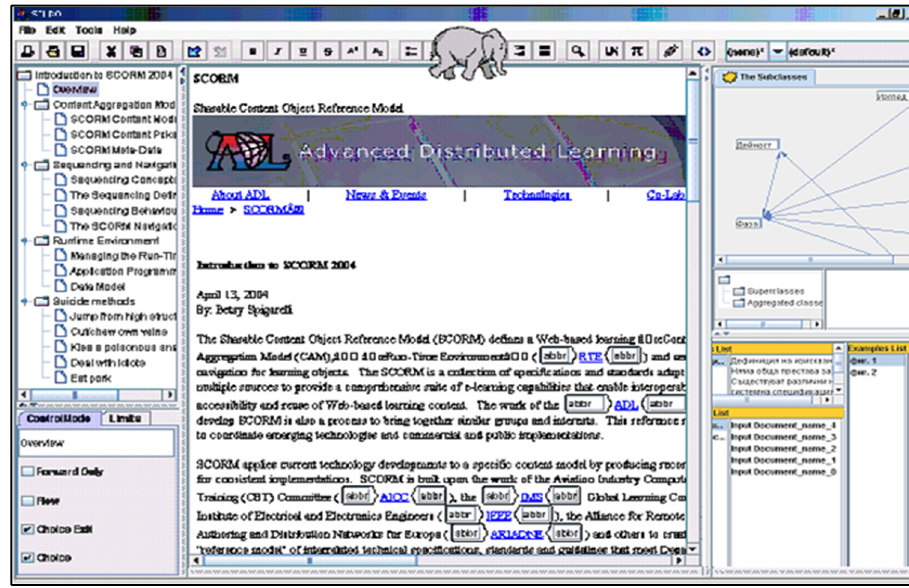
Figure 4. Selbo 2 editor (in Bulgarian).